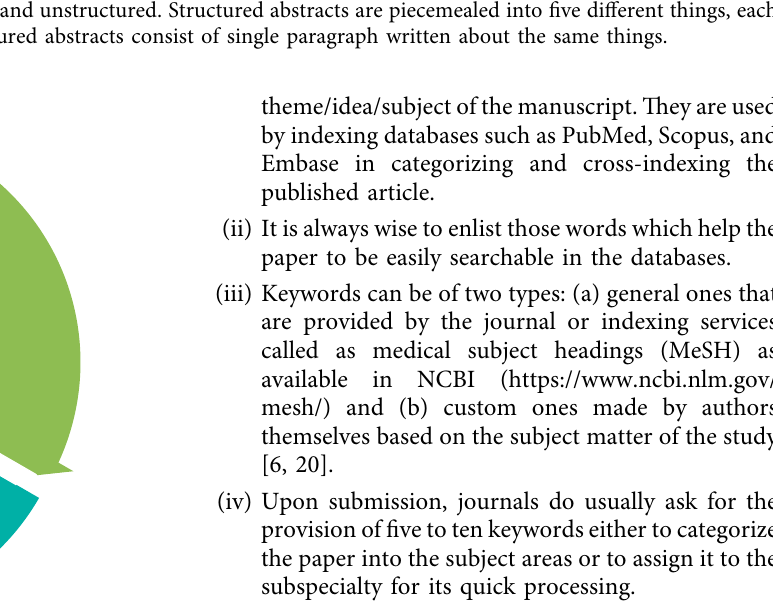
Figure 5: Three C concept followed while writing the